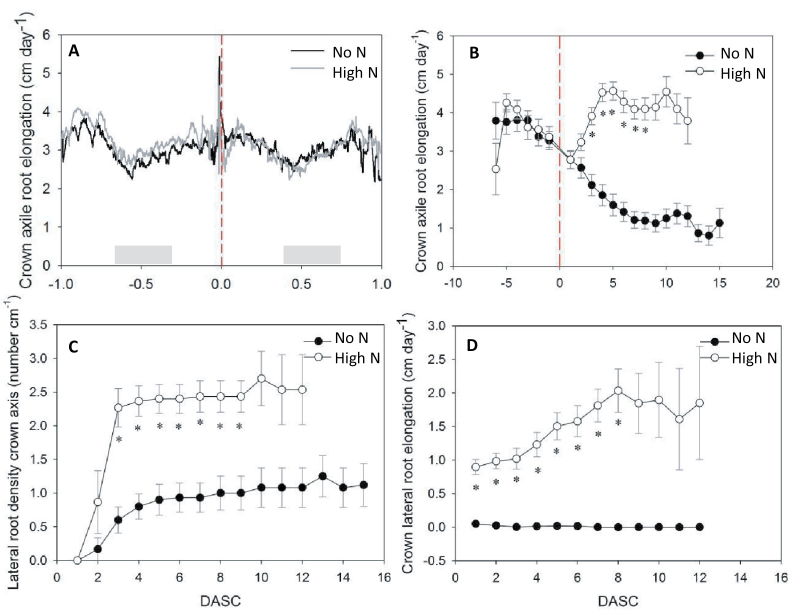
Root dynamics of crown axis and first order crown lateral roots in split-root rhizoslides subjected to either no nitrogen (N) or high (17mM) N after 15 d of growing without N. Crown axile root elongation determined by (A) tracking crown root tips with charge coupled device (CCD) cameras from -1 days after solution change (DASC) until 1 DASC, and (B) tracings of all the crown root tips over the whole experimental period. (C) Lateral root density on the crown root axis, and (D) elongation rates of these lateral roots. The dashed, red line indicates the time point of solution change, and the light grey squares night time. Values are means ±SE (n=2−13), asterisks indicate significant differences between the no N and high N roots (paired t-test with Bonferroni correction, P<0.05).